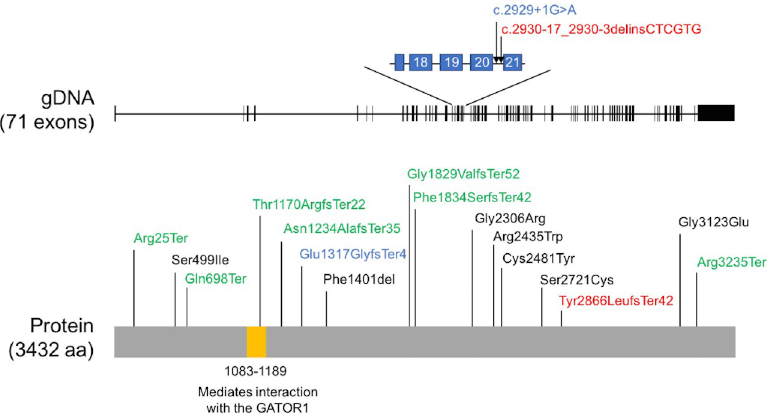
Fig 3. Localization of previously reported SZT2 variants. Red and blue font indicates the variants in patient 1 and 2, respectively. Green font indicates null variants. Black font indicates missense or in-frame deletion variants.